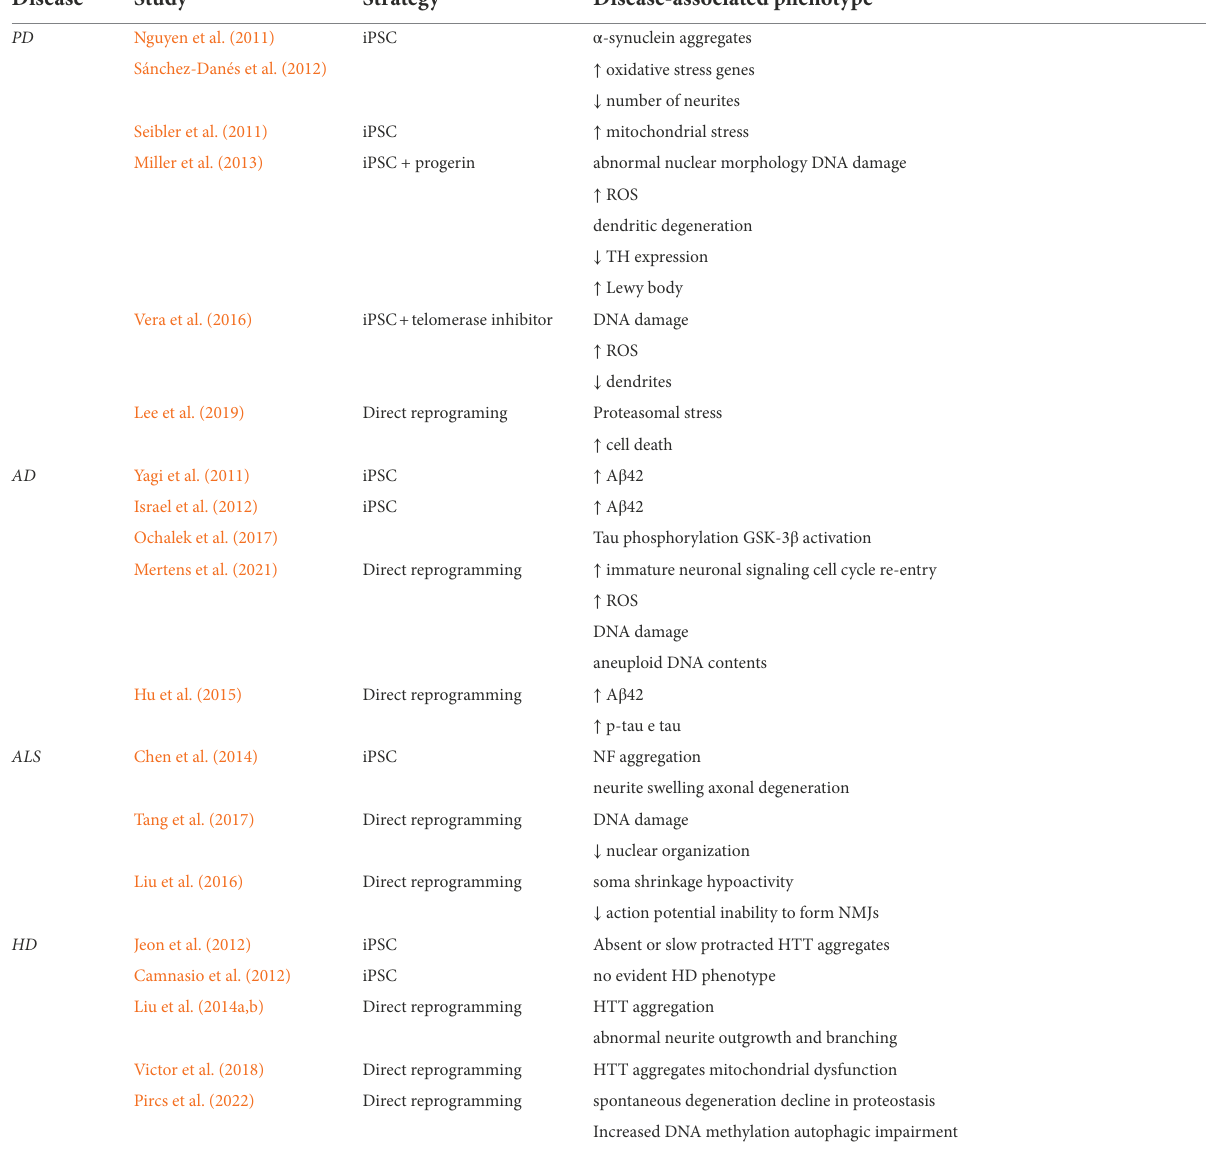
TABLE 1 Disease-associated phenotypes in iPSC-derived and direct reprogramming-derived neurons.